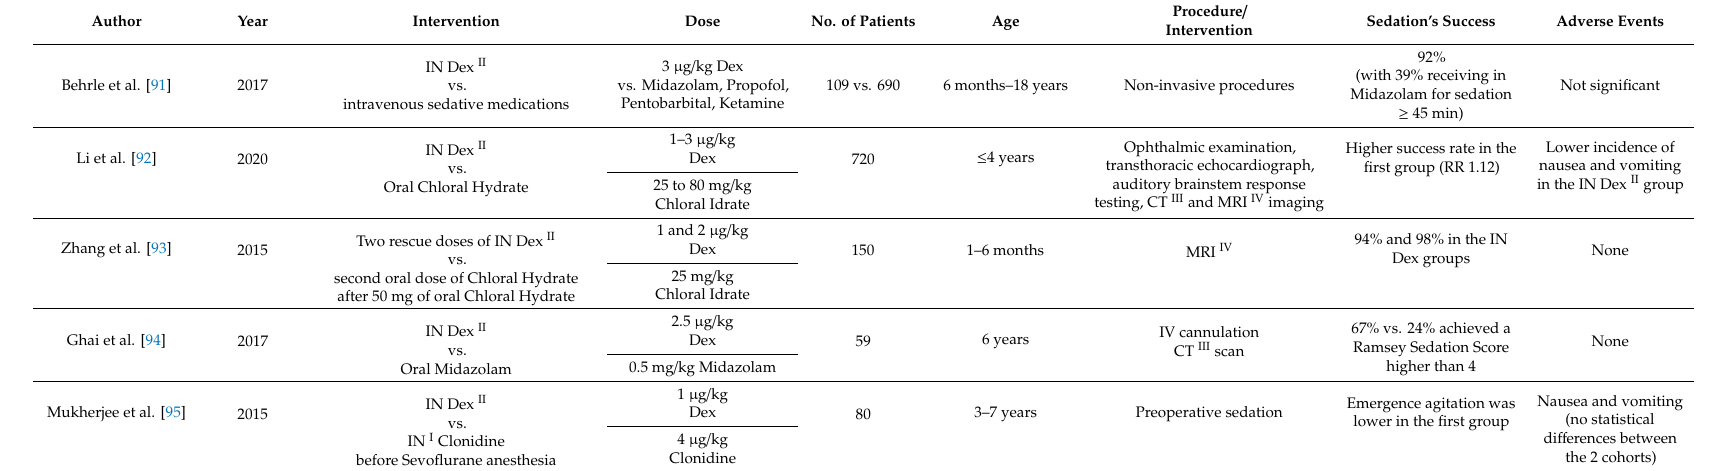
Table 2. Characteristics of the studies evaluating intranasal dexmedetomidine versus current available sedative agents.